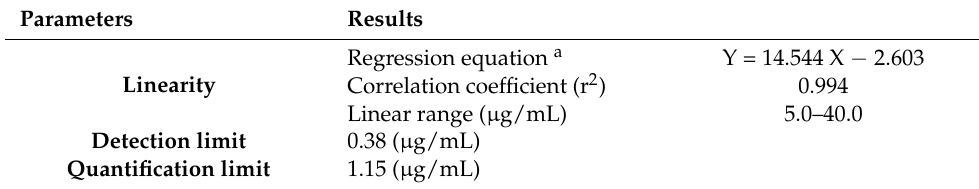
Table 2. Validation report of HPLC method for determination of